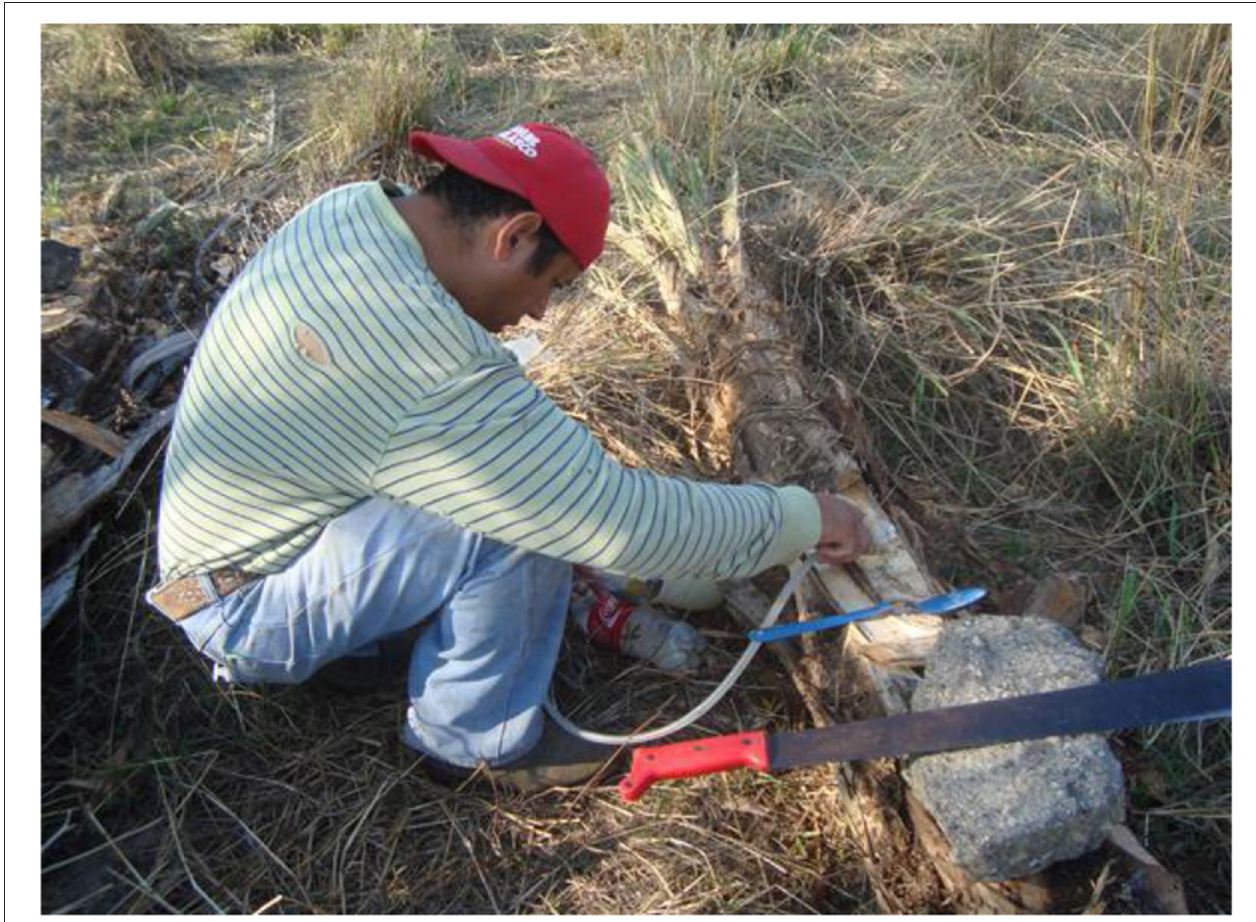
FIGURE 5 | Extraction of the sap accumulated in the palm “canoe,” using a plastic